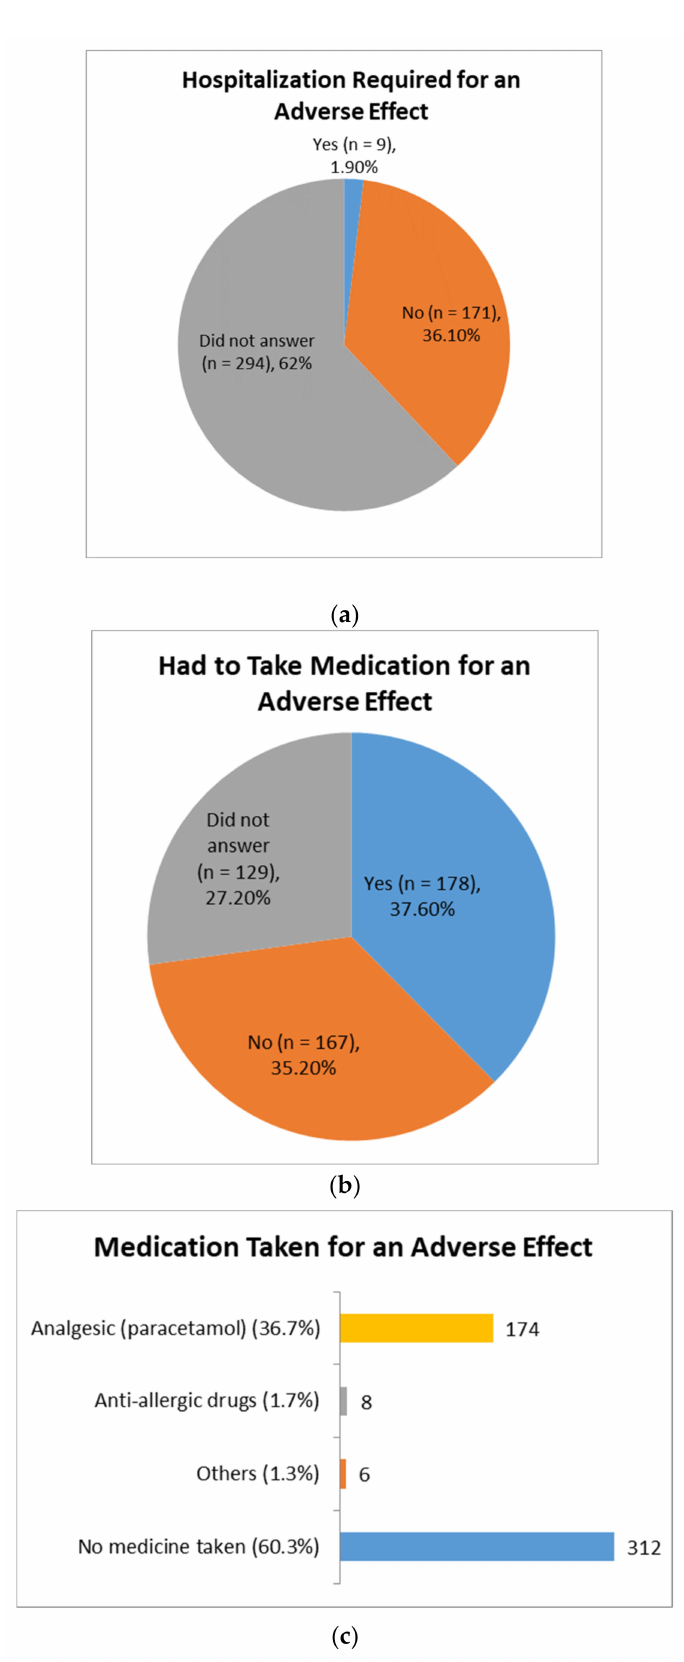
Figure 5. Post-vaccination adverse effect treatment of study participants. ( a ) Hospitalisation required for an adverse effect after vaccination. ( b ) Had to take medication for an adverse effect following vaccination. ( c ) Different medications taken for an adverse effect by the vaccine